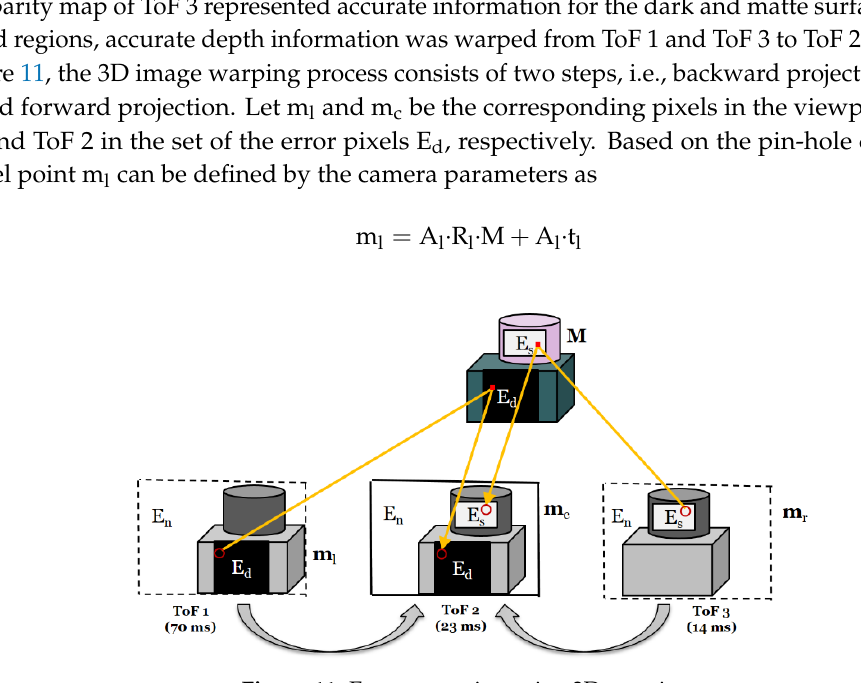
Figure 11. Error correction using 3D warping.